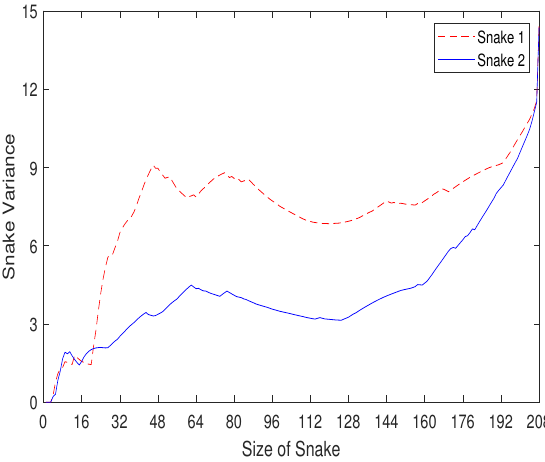
Figure 4. Variance of two snakes of the graph of links.